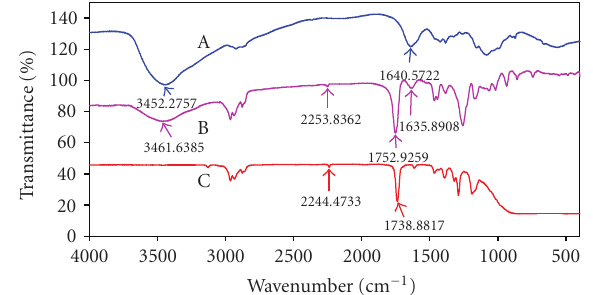
Figure 1: (A) Fourier transform IR spectra of chitosan; (B) chitosan-coated PBCA-NPs; (C) PBCA-NPs.